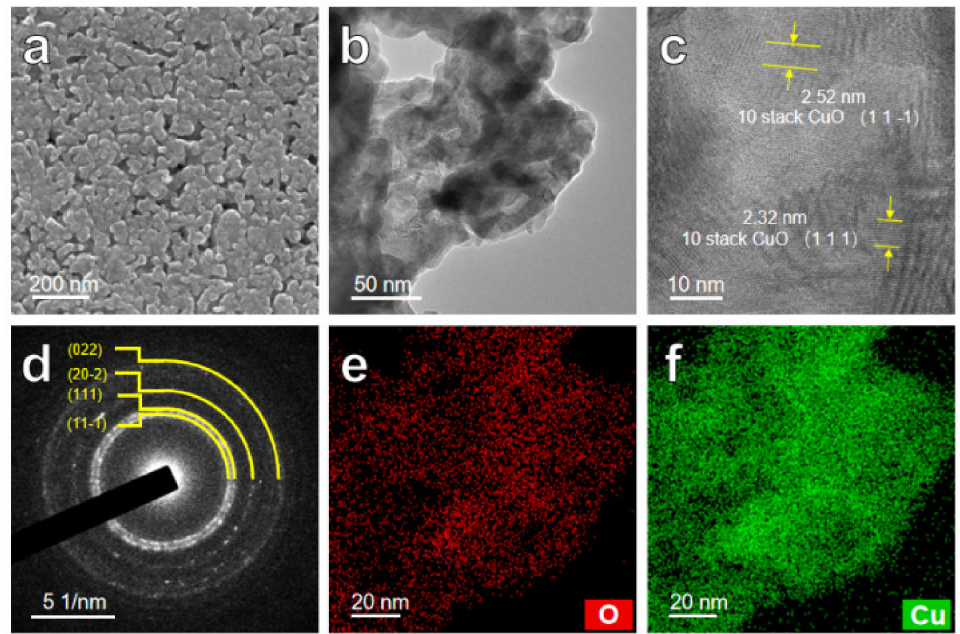
Figure 5. SEM and TEM images of nanoporous layer of the Co 3 O 4 @NP-CuO: ( a ) high magnification SEM image; ( b ) TEM image; ( c ) HRTEM image; ( d ) SAED pattern; EDS mapping images of ( e ) O; ( f )